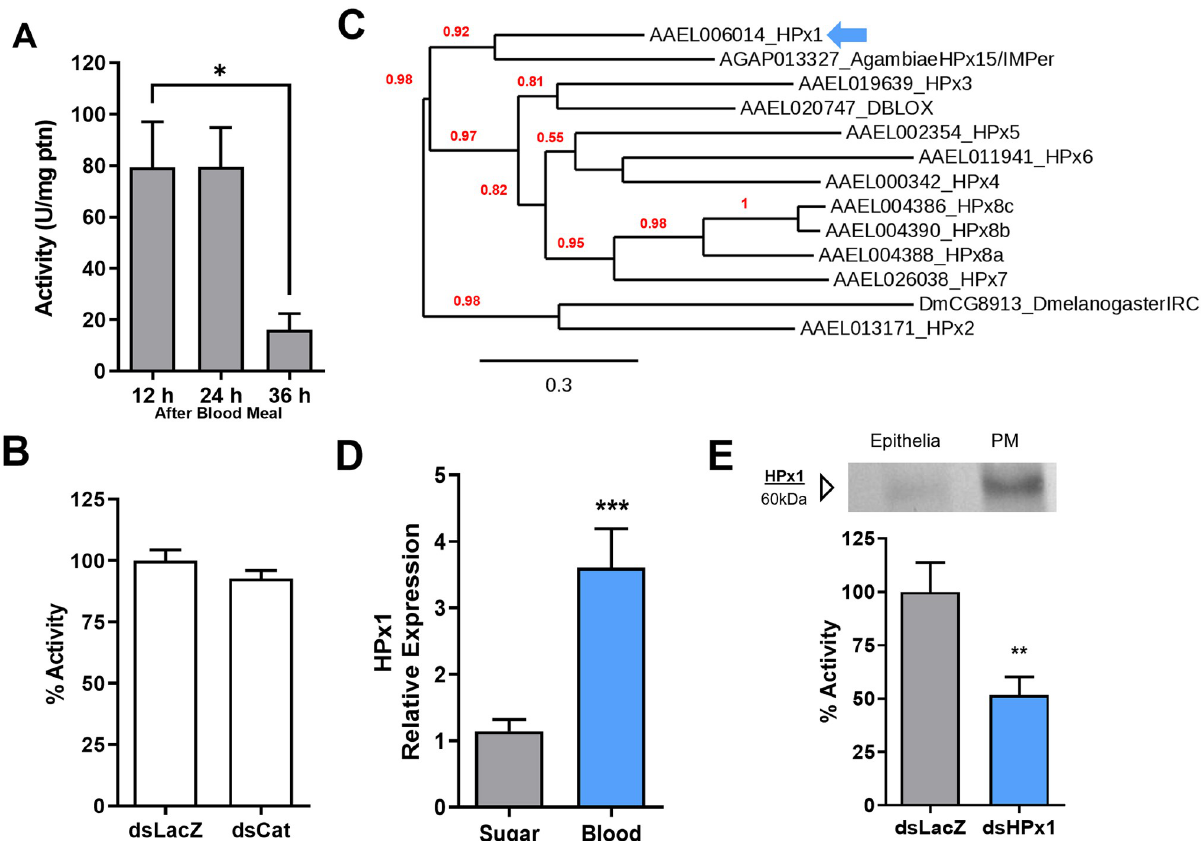
Fig 1. Hydrogen peroxide scavenging by the Aedes aegypti peritrophic matrix. A) PMs were dissected and pooled at different times after a blood meal (ABM), and their catalase specific activity was measured (12 h n = 5, 24 h n = 6; 36 h n = 5 pools of 5 PM). B) Catalase activity of PMs dissected from control (dsLacZ-injected) and catalase (AAEL013407-RB)-knockdown insects at 24 h AMB (dsLacZ n = 9; dsCat n = 9). C) Phylogenetic tree of heme peroxidases from Aedes aegypti (AAEL), Anopheles gambiae , and Drosophila melanogaster . Maximum likelihood analysis was performed, and the numbers in each branch represent bootstraps. (D) HPx1 expression in midguts at 24 h ABM relative to the sugar-fed control (Sugar n = 11; Blood n = 11). (E) Western blot of the HPx1 protein in 20 μ g of gut epithelia and PM extracts at 18 h ABM and catalase activity of PMs dissected from control and HPx1-knockdown insects (dsLacZ n = 8; dsHPx1 n = 13). The full western blot membrane is shown in S1E Fig. Data are the mean +/- SEM. �� p > 0.005, ��� p < 0.001 for the T test for D and E.